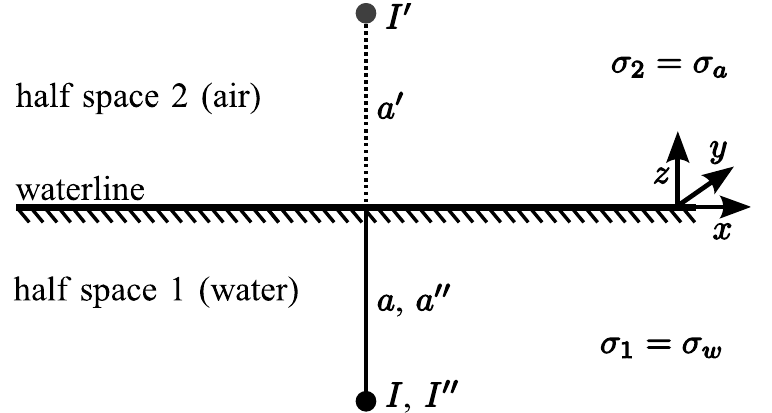
Figure 2. Setup for the method of images. The vicinity of a conducting half-space in front of a point current source I can be considered by introducing the image sources I’ and I’’ .